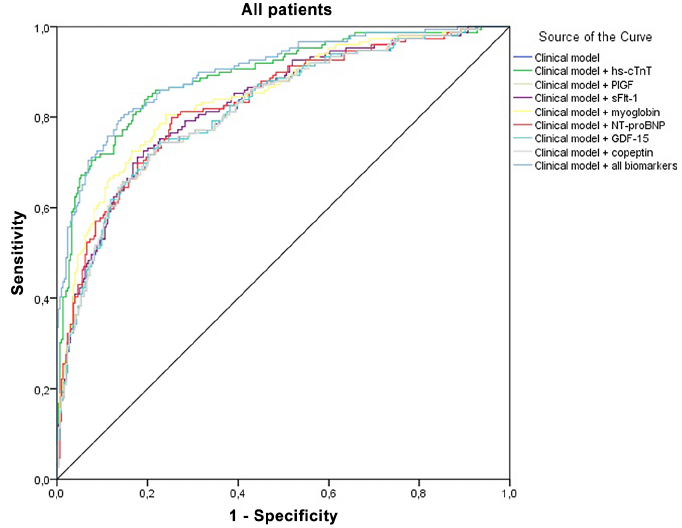
Fig 2. Receiver-operating-characteristic curves of the clinical model with the various biomarkers, high sensitive cardiac troponin T (hs-cTnT), placental growth factor (PlGF), fms-like tyrosine kinase-1 (sFlt-1), myoglobin, N-terminal prohormone B-type Natriuretic Peptide (NT-proBNP), growth differentiation factor-15 (GDF-15) and copeptin. (The ROC curve shown is from the first imputation set)